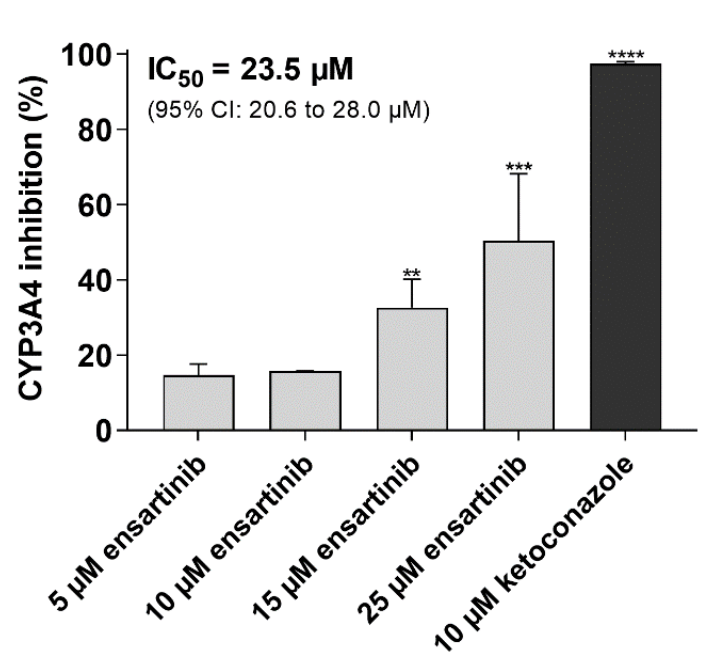
Figure 4. Effect of ensartinib on human CYP3A4-mediated metabolic activity in HepG2-CYP3A4 cells. Cells were pre-incubated with the tested drugs for 10 min, then the reaction was initiated by adding the substrate (luciferin-IPA). The reaction was stopped after 45 min and the samples’ luminescence was measured to assess the cells’ viability. Metabolic data were normalized to viability values to compensate for possible inaccuracies caused by non-uniformity in cell growth and / or false-positive results due to drug cytotoxicity. The viability values were then re-normalized as inhibition percentages. The plotted values are means ± SD based on three independent experiments. Statistical analysis was performed using background-subtracted luminescence data normalized to viability values using one-way ANOVA followed by Dunnett’s post hoc test (** p < 0.01; *** p < 0.001; **** p < 0.0001 compared to